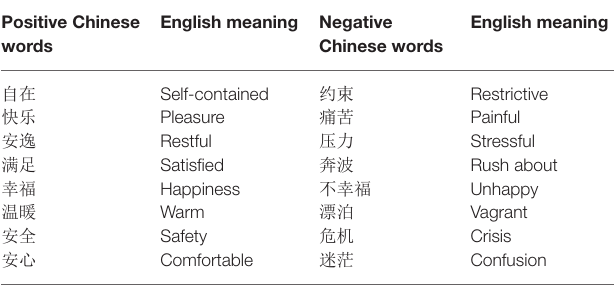
TABLE 2 | Chinese-English translation of the lexical stimulative materials. Positive Chinese